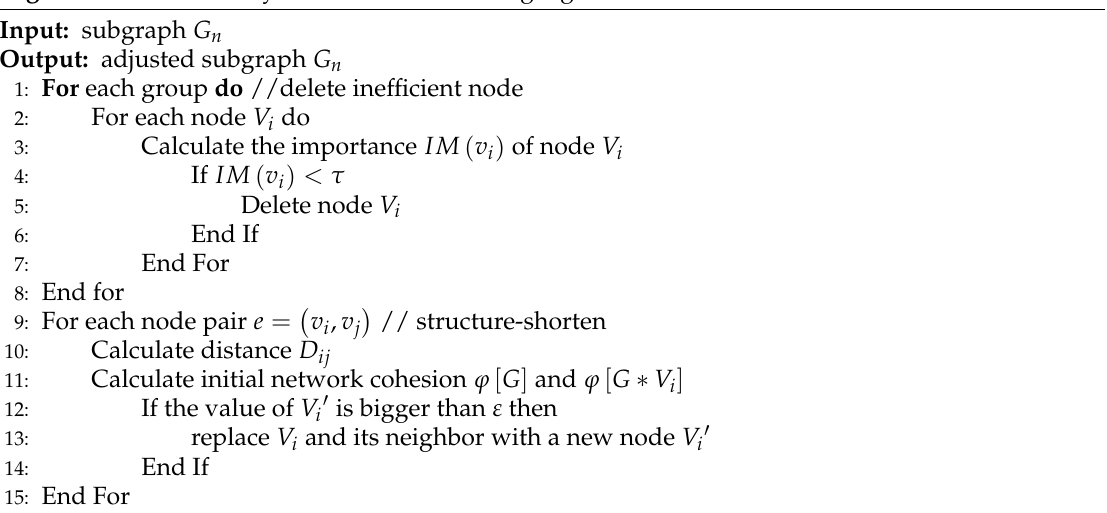
Algorithm 2 Community based data-forwarding